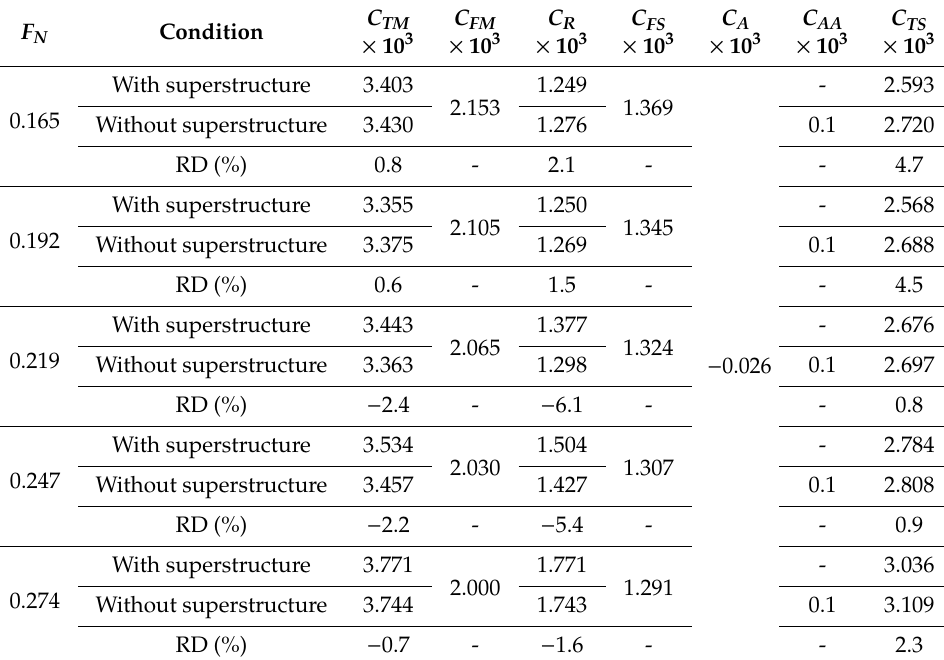
Table 5. Factors for calculating the air resistance coefficient.